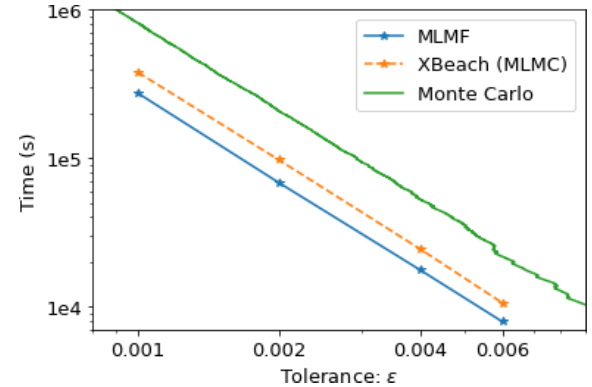
Figure 20. Comparing the computational cost required to achieve tolerance (cid:15) using MLMF, XBeach with MLMC and the Monte Carlo method for the Carrier–Greenspan test